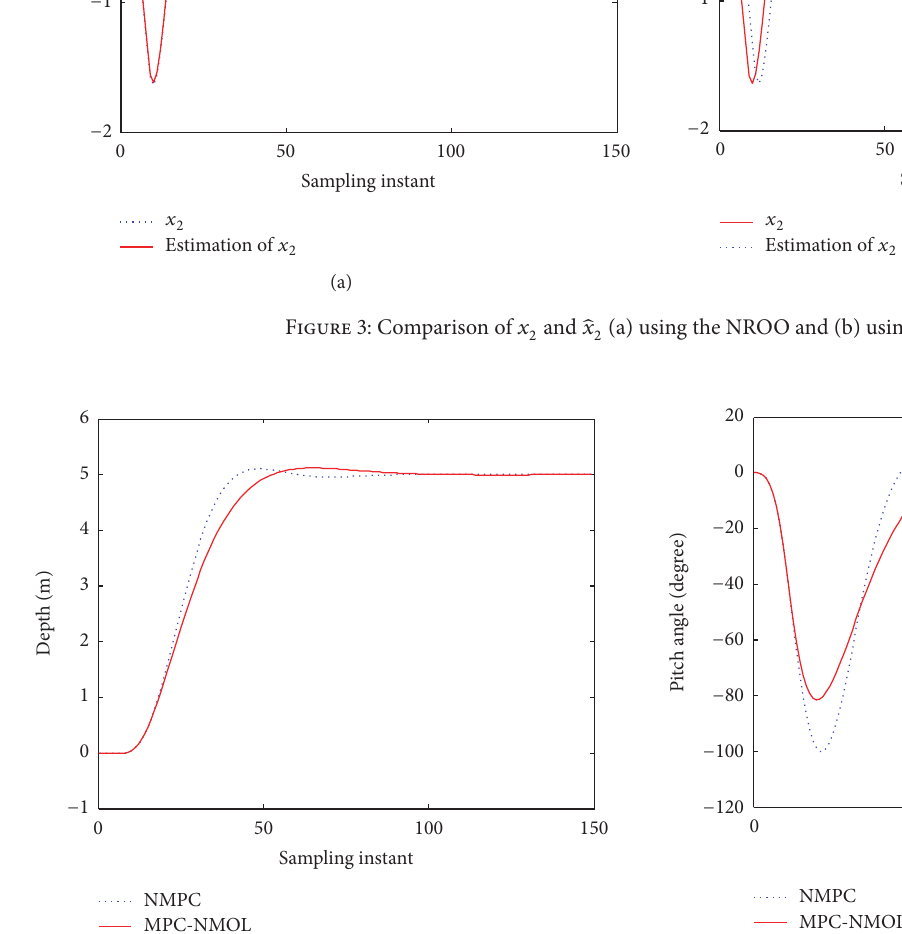
5.2. Implementation of MPC-NMOL. The parameters of MPC , and 𝑅 = 10 . are chosen as 𝑁 𝑝 = 30 , 𝑁 𝑢 = 2 , 𝑄 = 𝐼 𝑁 𝑝 ×𝑁 𝑝 The initial values of state variables are all zero. The waves disturbance exposed on REMUS is assumed at a level 3 sea state, 𝐻 𝑠 = 0.88 ( m ) , 𝛽 = 45 ∘ , 𝐶 𝑑 = 0.65 , 𝐶 𝑚 = 1.95 , and 𝑁 = = 1.51 ( m / s ) , the desired depth is 271 . The surge speed is 𝑈 𝑐 5 ( m ) , and pitch angle is 0 ∘ . Input and output constraints are